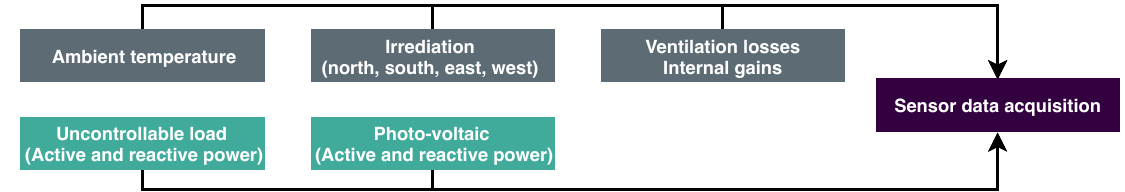
Figure 5. Schematic of a sensor data acquisition system use in three-phase HEMS.